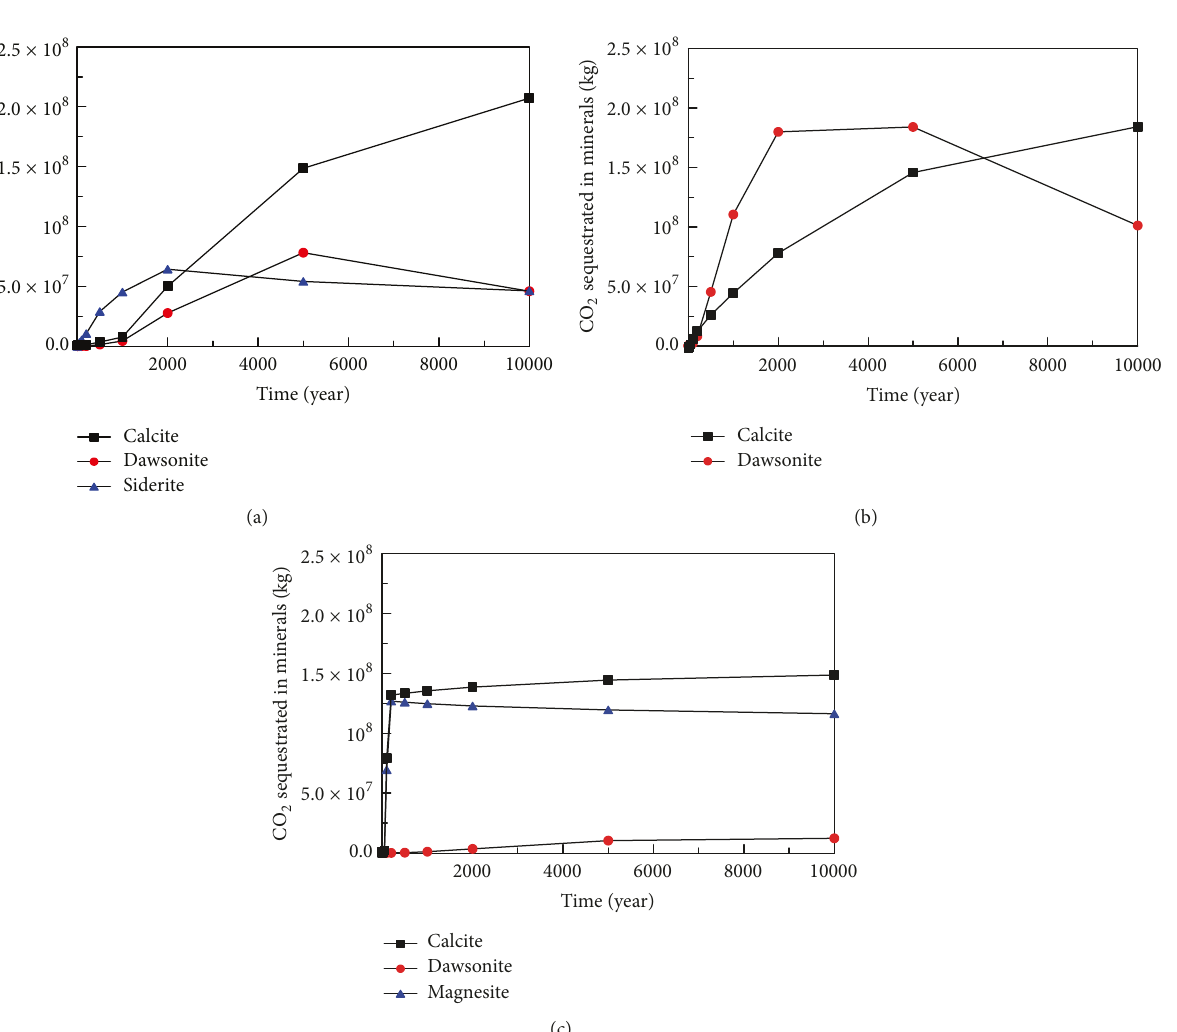
Figure 4: The amounts of CO 2 sequestrated in minerals for the Liujiagou formation (a), Shiqianfeng formation (b), and Shihezi formation (c) at different